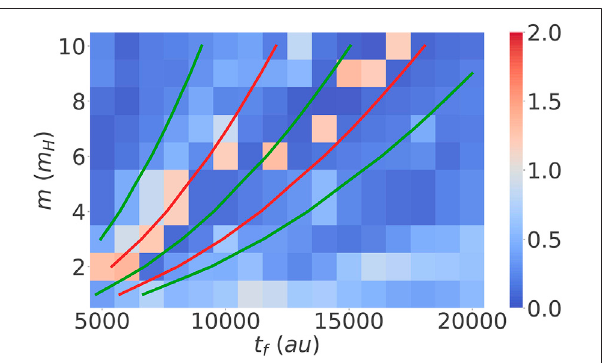
FIGURE5| Erroraccordingto Eq.31 asafunctionofdifferent fi naltimes and masses.Greenlinesrepresent anoddnumber ofhalfharmonic oscillation periods for the corresponding mass ( 2 n + 1 ) T / 2 with n (cid:1) 1 , 2 , 3 and red lines represent an integer number of periods nT with n (cid:1) 2 ,